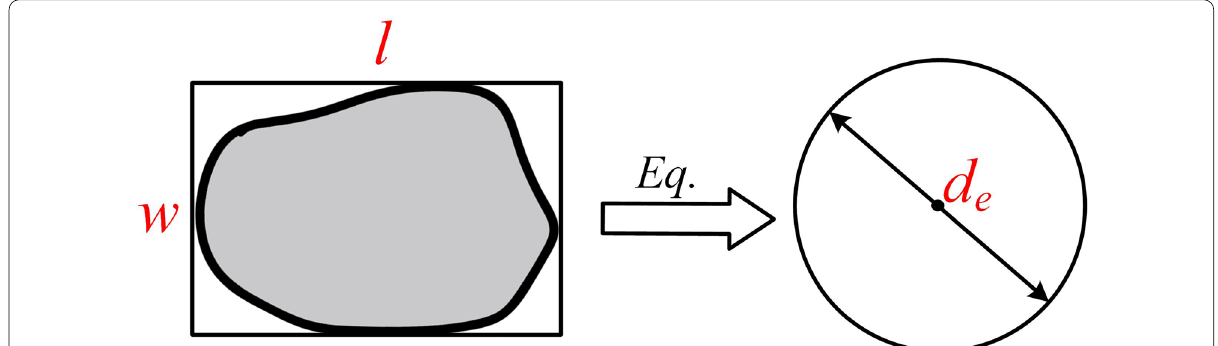
Figure 5 Diagram of equivalent diameter calculation for sand particles